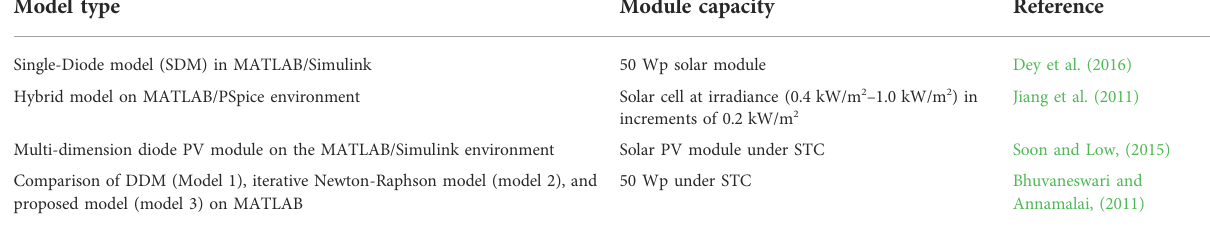
TABLE 3 PV array models designed in software environments ’ Model